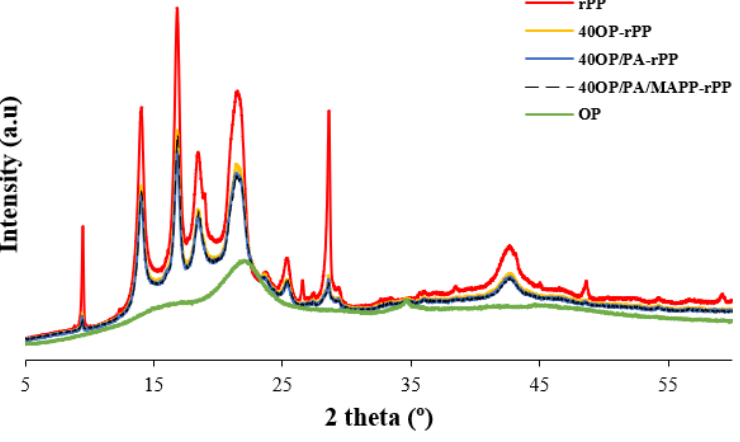
Figure 14. OP, rPP and biocomposites XRD-diffraction diagrams overlayed.